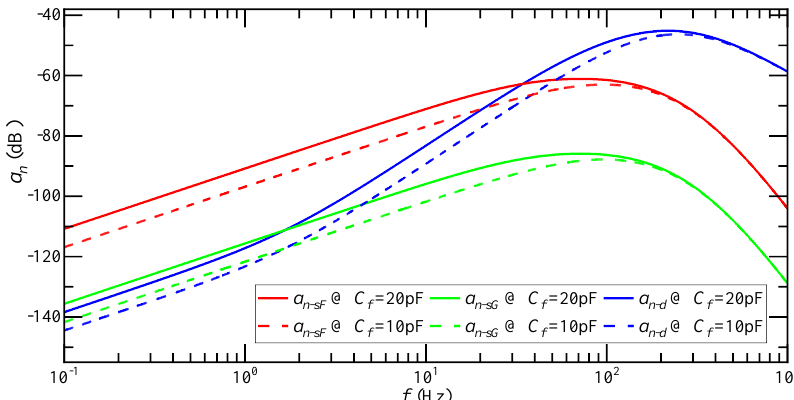
Figure 12. Amplitude-frequency characteristic curve of 𝑎 𝑛 when 𝐶 𝑓 decreases by one time. When 𝑉 𝑠 and 𝐶 𝑓 are adjusted, the change rule of the mean magnitude of 𝑎 𝑛 is as shown in Figure 13. Increasing 𝑉 𝑠 is more effective than decreasing 𝐶 𝑓 ; when 𝑉 𝑠 = 6.55 𝑉 and 𝐶 𝑓 = 4.8 𝑝𝐹 , the inhibition effect on 𝑎 𝑛 is the same.